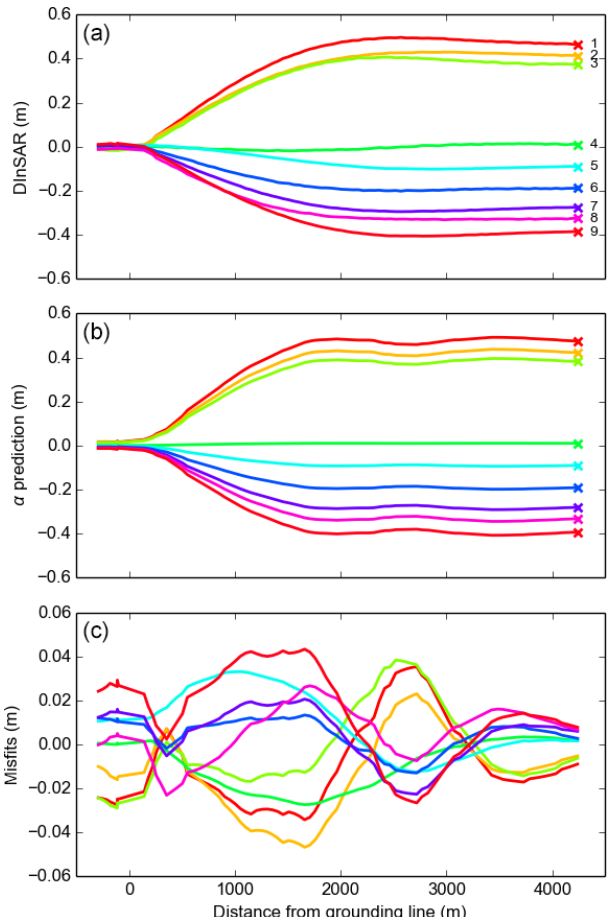
Figure 3. Reconstruction of vertical displacement along the profile during the 12 times of satellite overpasses on the southern McMurdo Ice Shelf. (a) A combination of an empirical displacement model with adjusted CATS2008a tide-model output, (b) their least-square adjustment and (c) the final vertical displacement profiles during the times of SAR data